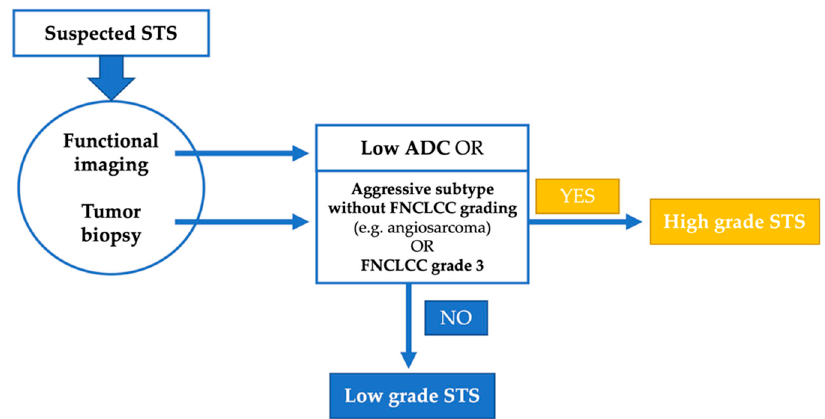
Figure 5. Suggestion of a combined grading system for soft tissue sarcoma (STS).